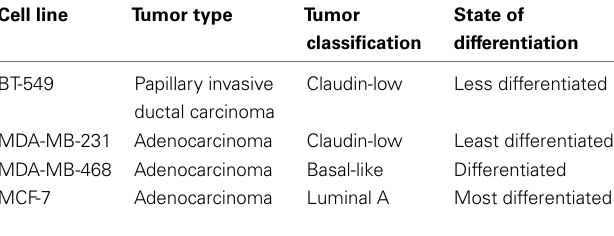
Table 1 | Breast cancer cell lines used.